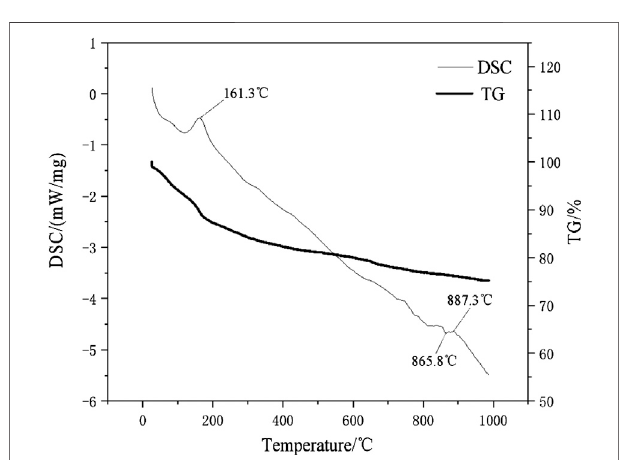
FIGURE 12 | DSC-TG patterns of paste specimens of D2 group.